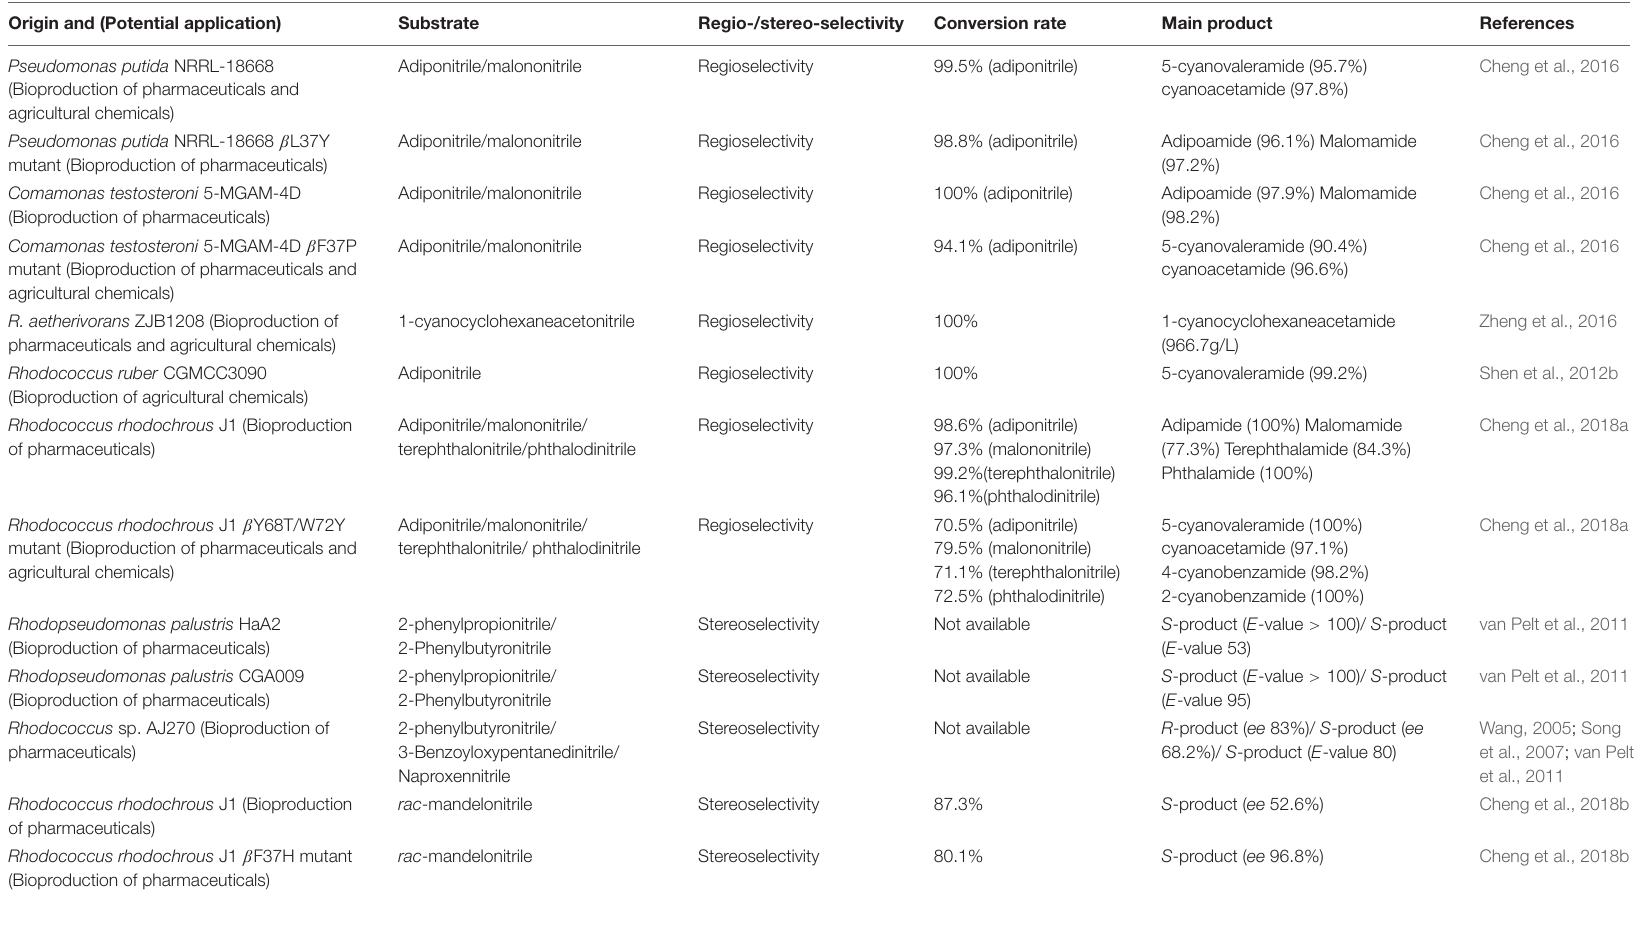
TABLE 2 | Regio- and Stereo-selective NHase reported in recent